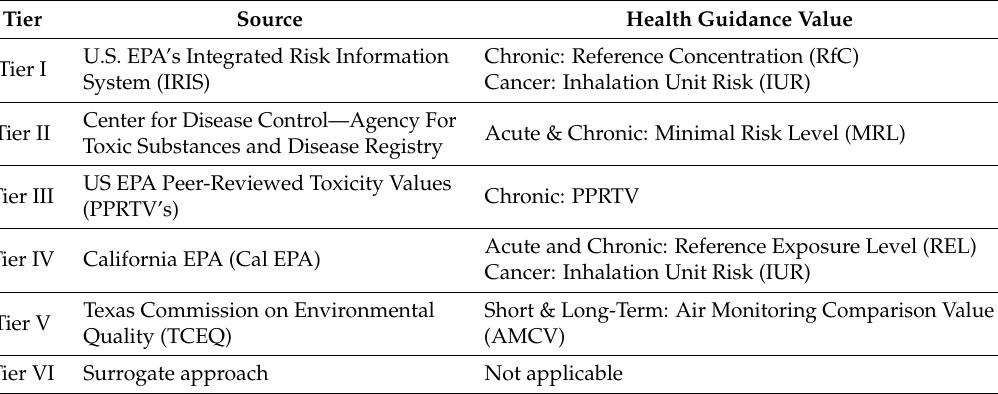
Table 2. Tiered approach for selecting acute and chronic non-cancer health guidance values